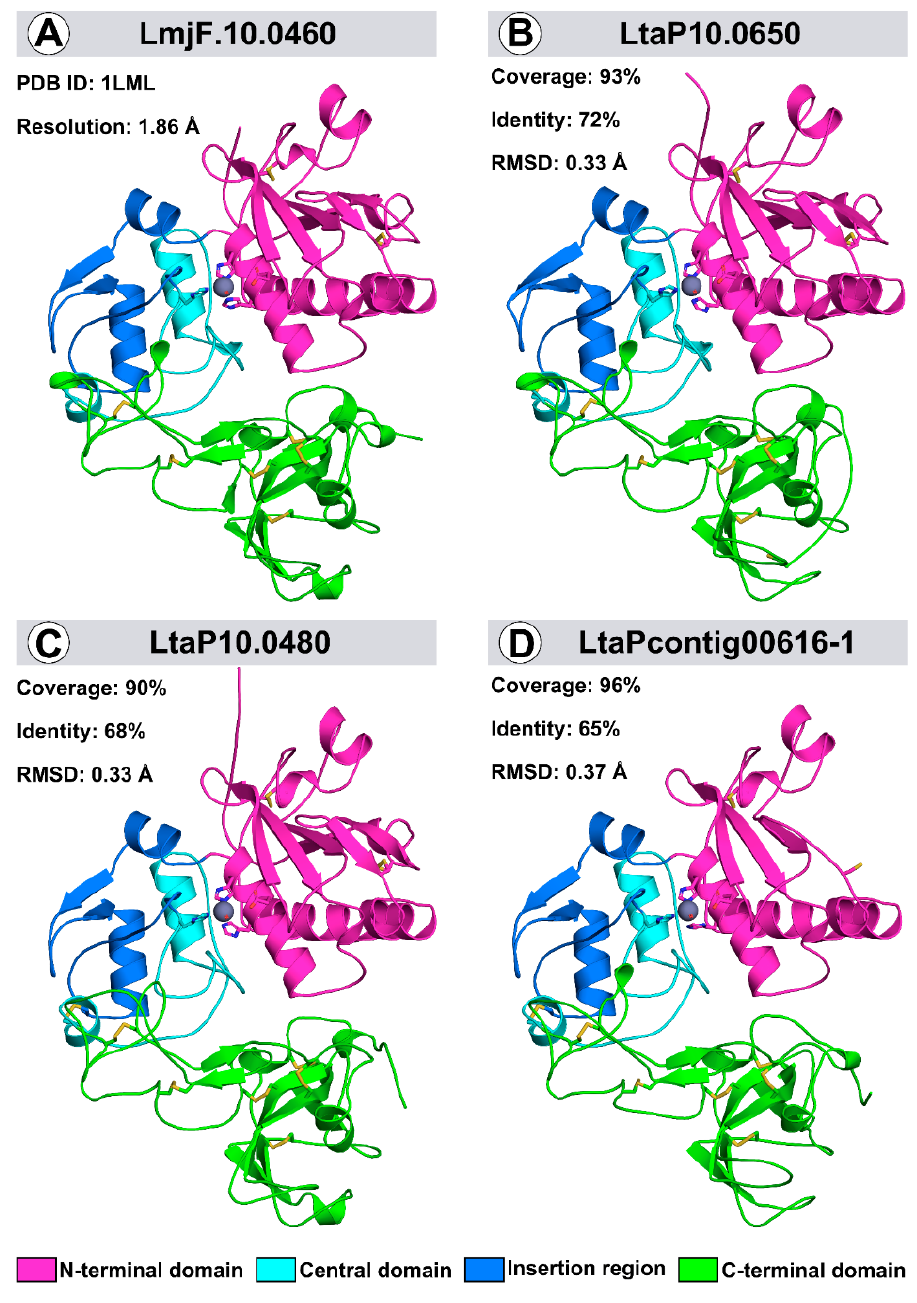
Figure 2. Three-dimensional structures of L. major (PDB ID: 1LML) and L. tarentolae leishmanolysin 3D-models. The PDB ID of the template and resolution are given in the upper left corner of the upper left quadrant, while the RMSD, coverage degree, and identity between models and the template appear in the upper left corner of the other three. The N-terminal, central region, and C-terminal domains are identified in pink, light blue, and green, respectively. The disulfide bonds are represented by sticks in yellow, the insertion region is identified in dark blue, and the zinc ion appears as a sphere in dark grey.